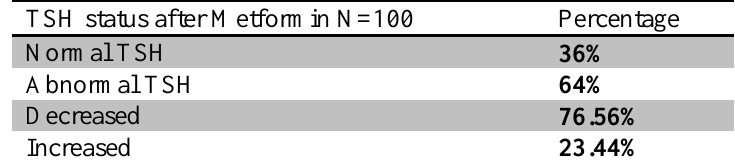
Table2: summarize the TSH status after treatment with Metformin in the total 100 patients.